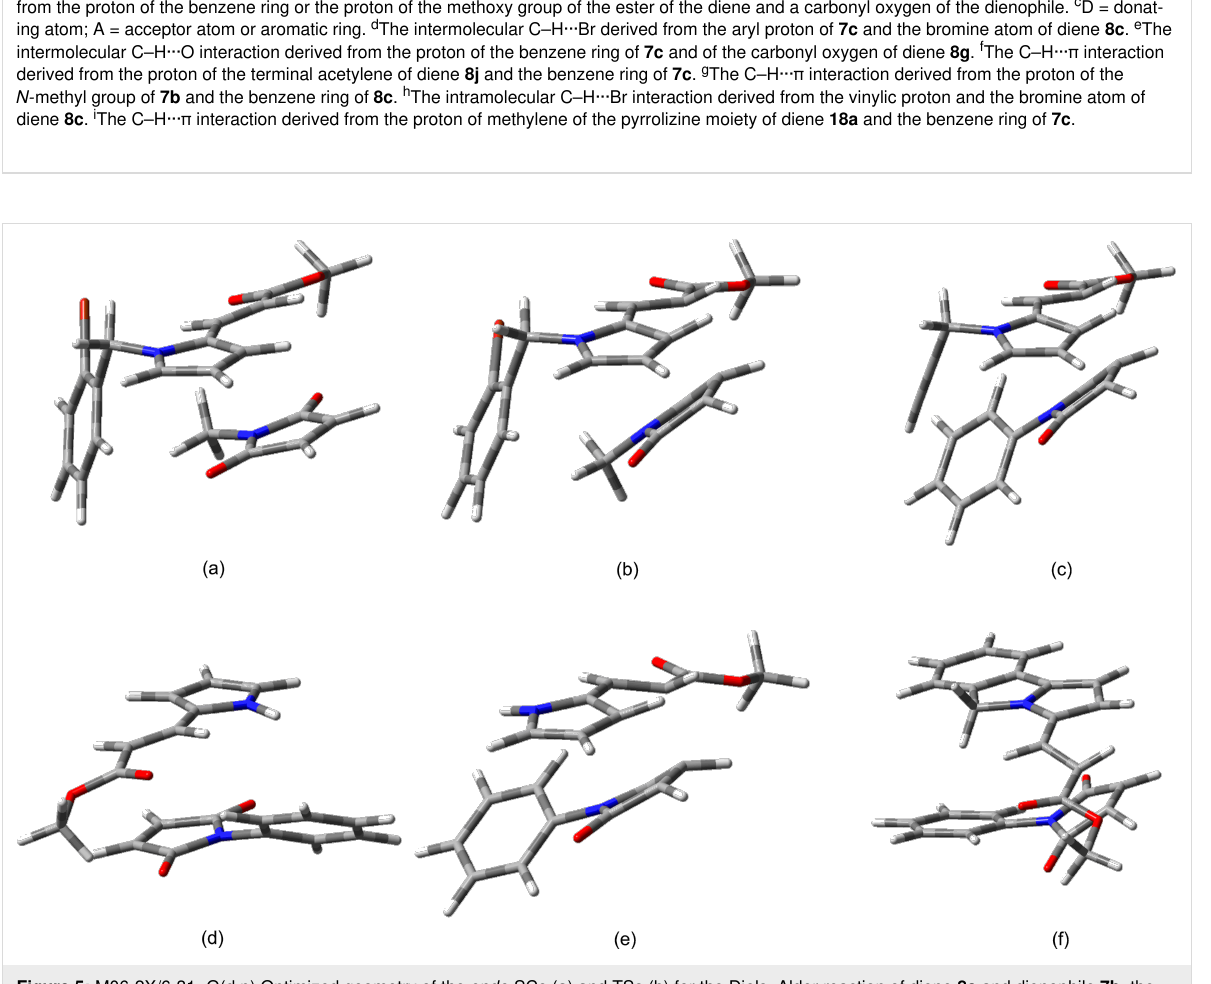
Figure 5: M06-2X/6-31+G(d,p) Optimized geometry of the endo SCs (a) and TSs (b) for the Diels–Alder reaction of diene 8c and dienophile 7b , the endo TSs (c) of the reaction of 8j and 7c , the endo approach of the SC (d) and TS (e) for the cycloaddition of 16a and 7c , and the endo TS (f) for the cycloaddition of 18a and 7c